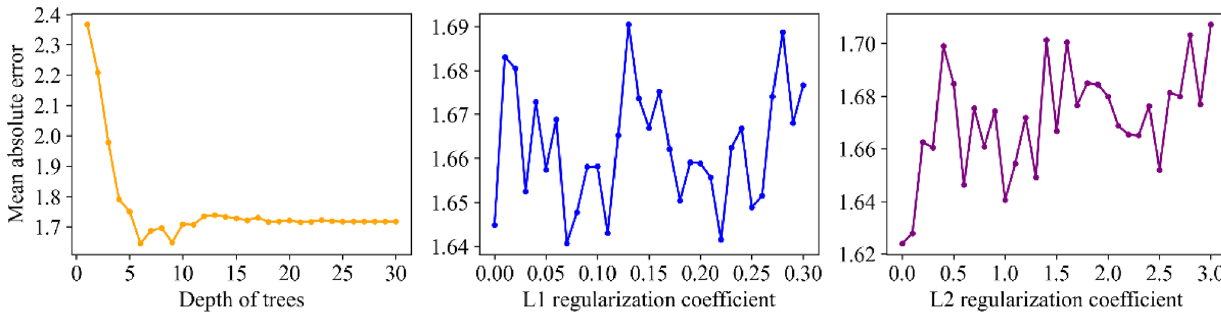
Fig. 10 MAE function with the other parameters